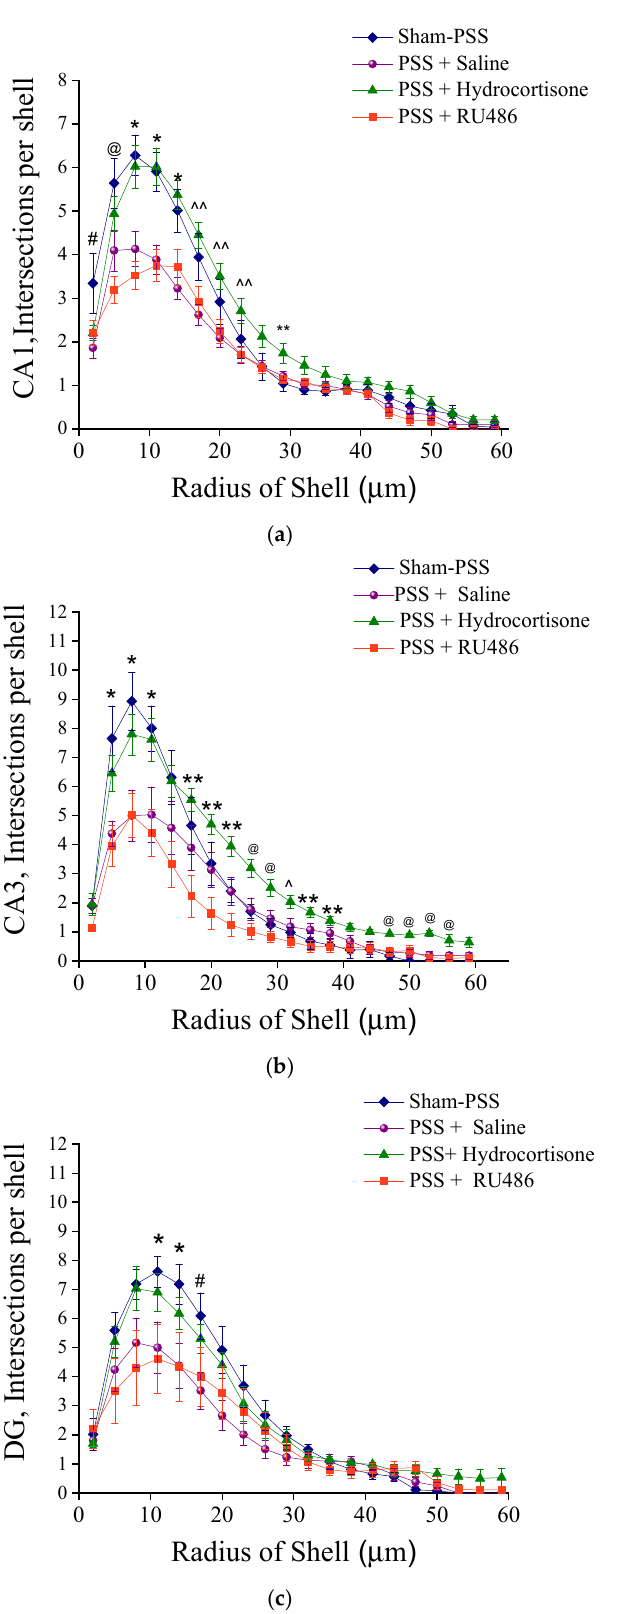
Figure 10. Sholl-analysis for intersections per 3 mm radial unit distance from sham-PSS, PSS +Saline, PSS + Hydrocortisone 25 mg/kg and PSS + RU486 30 mg/kg groups. Results displayed as mean ± S.E.M. ( a ) CA1 hippocampal subregion at day 8 post PSS-exposure : # Sham-PSS ≠ PSS-Saline- p < 0.025. * Sham-PSS, PSS-Hydrocortisone ≠ PSS-Saline, PSS-RU486- p < 0.015. ^^ PSS-Hydrocortisone